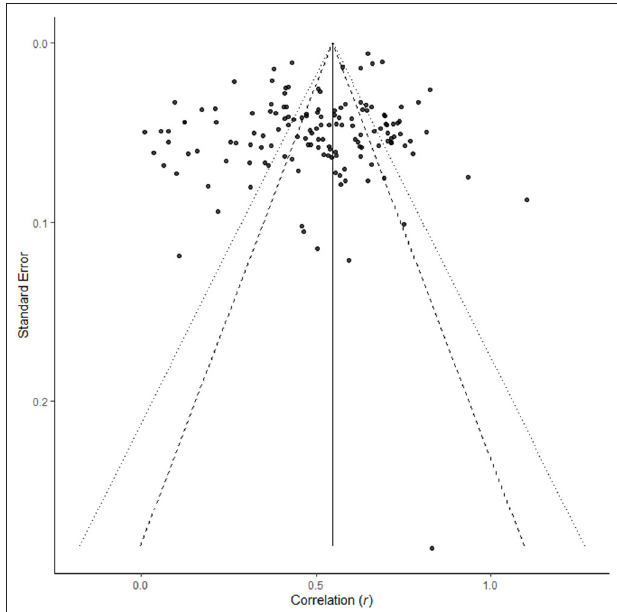
FIGURE 6 | Trim-and-fill funnel